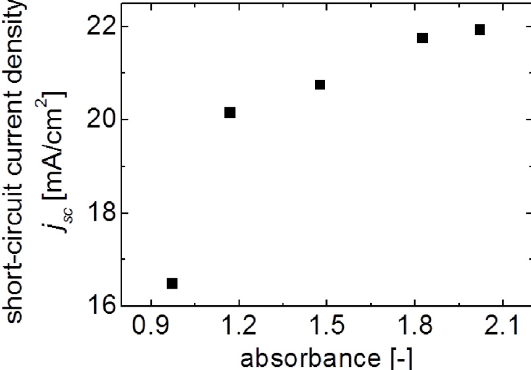
Fig. 4. Short-circuit current density j sc as a function of ef- fective absorbance = α eff d . The short-circuit current density of the cells was measured under standard AM1.5 illumination (ex-situ). The effective absorption coefficient was determined using exponential fits of the transient transmission signal at a wavelength of 656 nm (in-situ). The final thickness d of the so- lar cells was measured after deposition using a surface profiler